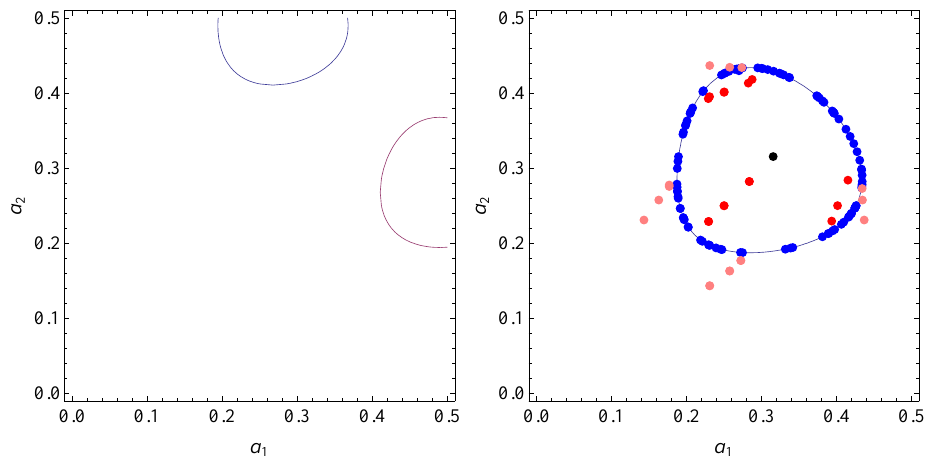
Figure 8: Degenerate 1D manifolds showing the possible values of a gap Ansatz (left) and the 2-gap Ansatz (right, continuous line) for p = 0.02, ξ = 1 = − 2 [ Eq. (123) ] . The discrete blue points are from direct numerical mini- and ξ 4 mization starting from random configurations (section 4.2.3), and fall precisely onto the calculated line. The black point is the optimal metal (same parameters). Away from integrability ( λ ̸ = 2), the continuous degeneracy is lifted since all the random configurations fall onto the same set of discrete points, related by translation sym- metry: pink points for λ = 1.98,1.95,1.9, red points for λ = 2.03,2.06,2.1 (same other